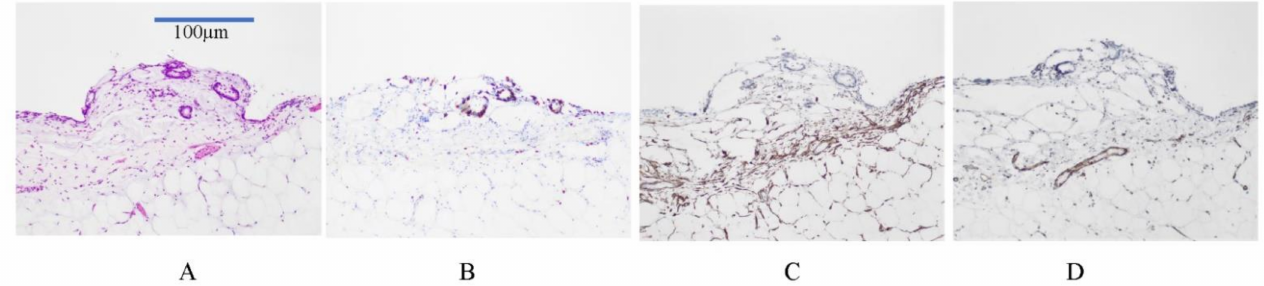
Figure 16. ( A ) Micrometastasis of differentiated adenocarcinoma growing on the small bowel mesen- tery (HE staining). Stromal induction is already found. The specimens are obtained from macro- scopically normal paracolic gutters of patient with gastric cancer. ( B ) Ki67 staining shows positive immunoreactivity in cancer cells. ( C ) CD34 immunoreactivity is found at the front of micrometastasis invasion. ( D ) No angiogenesis is found in the stroma of micrometastasis (CD31